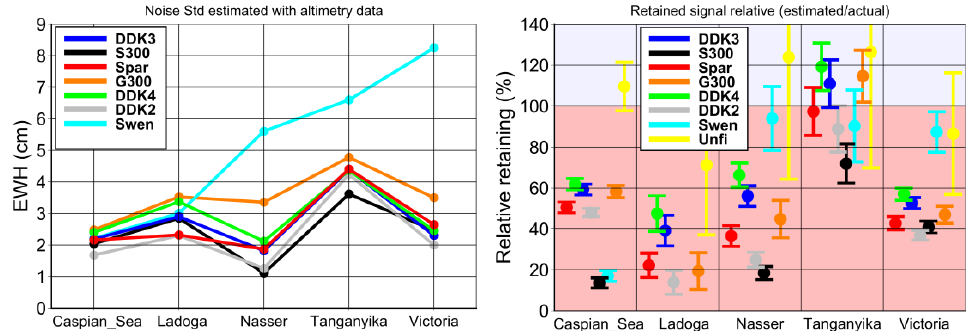
Figure 8. Assessment of the time-series of mean mass anomalies per lake extracted from the eight GRACE solution time-series under consideration: noise standard deviation ( left ) and relative signal retaining ( right ). Table 4. The second and third columns summarize the results of the lake tests, showing the mean val- ues of the estimated noise StD and weighted mean values of the relative signal retaining, respectively. Both quantities are the result of averaging over all five considered lakes. The last column reports the global estimates of noise standard deviations obtained with the VCE